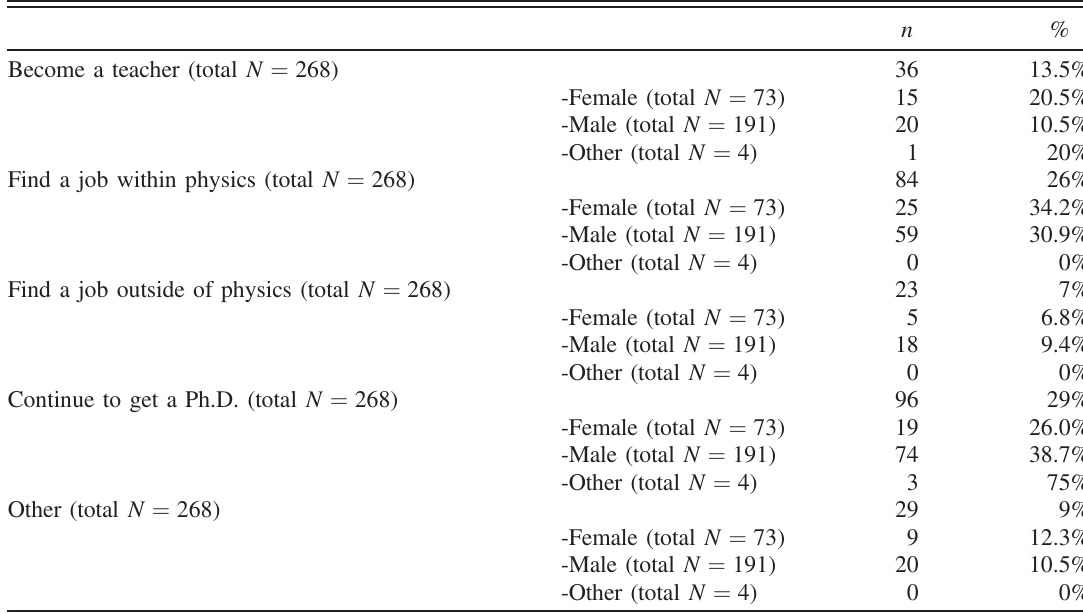
TABLE III. Bachelor ’ s and master ’ s career